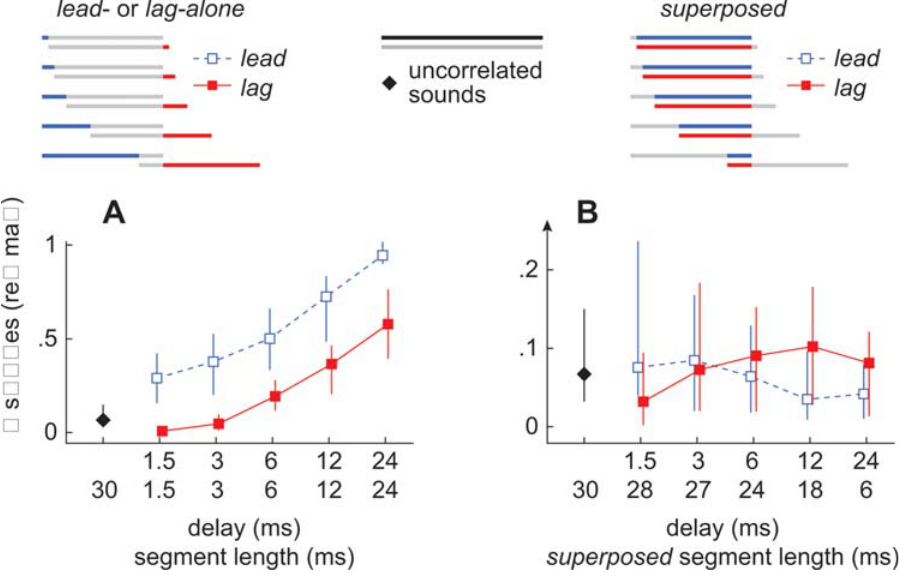
Figure 3. Summary of neural responses evoked during the lead-alone , lag-alone , and superposed segments. ( A ) Responses evoked during the lead-alone (open, blue, squares) and lag-alone (closed, red, squares) segments. Each data point represents the median number of spikes, normalized to the average response evoked, in each cell, by 30 ms sounds ( . 50 repetitions) presented from the center of its SRF [11]. Vertical lines indicate the first and third quartiles of each response. The upper row of numbers along the abscissa represents the onset-delay and the bottom row represents the length of each segment. ( B ) Responses evoked during the superposed segments when the target led (open, blue, squares) or lagged (closed, red, squares). Responses evoked by two, simultaneous, uncorrelated, noise-bursts from the target and masker loci are indicated by black diamonds ( A , B ). Note that the ordinate axis in panel B is expanded relative to that of panel A .